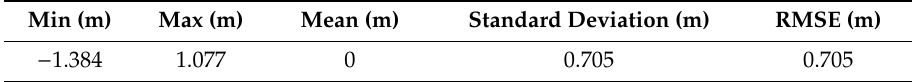
Table 6. Statistical values of the residuals for the North coordinates resulting from datum transformation UTM / ED50 to UTM / WGS84 based on a simplified approach (translation).